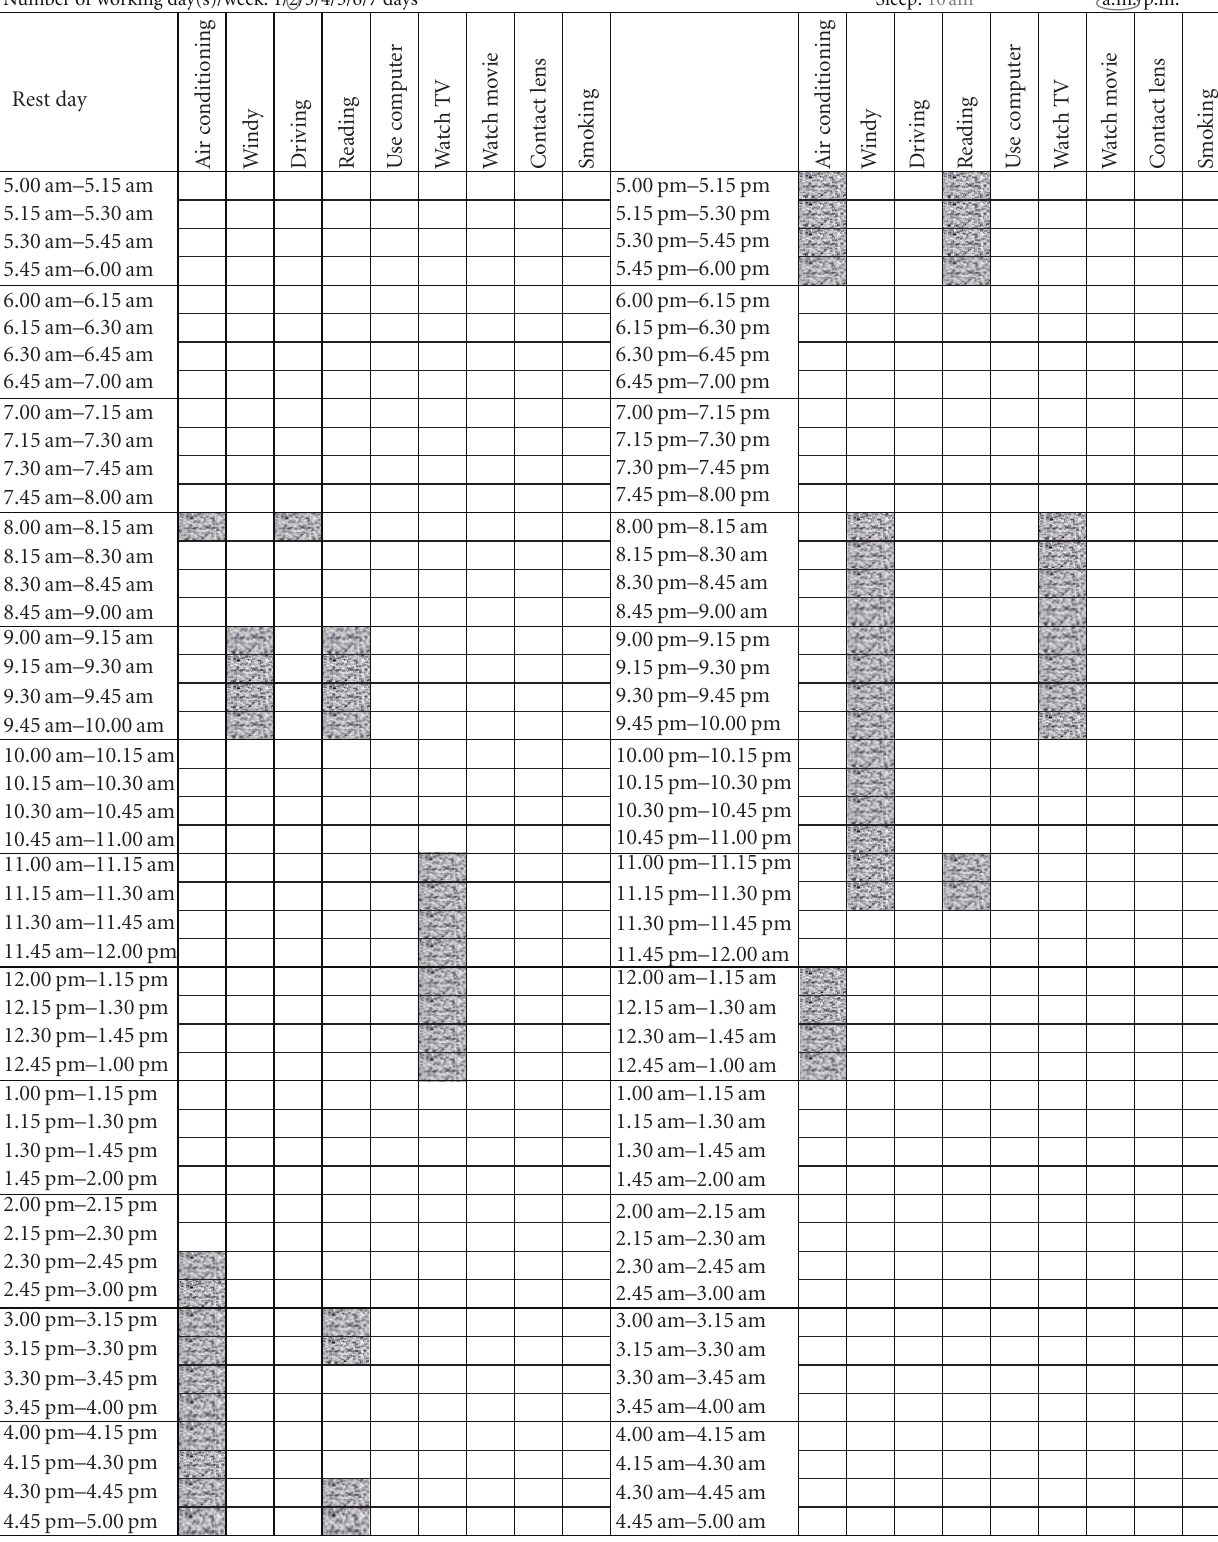
Figure 1: An example of an activity log as filled in by a